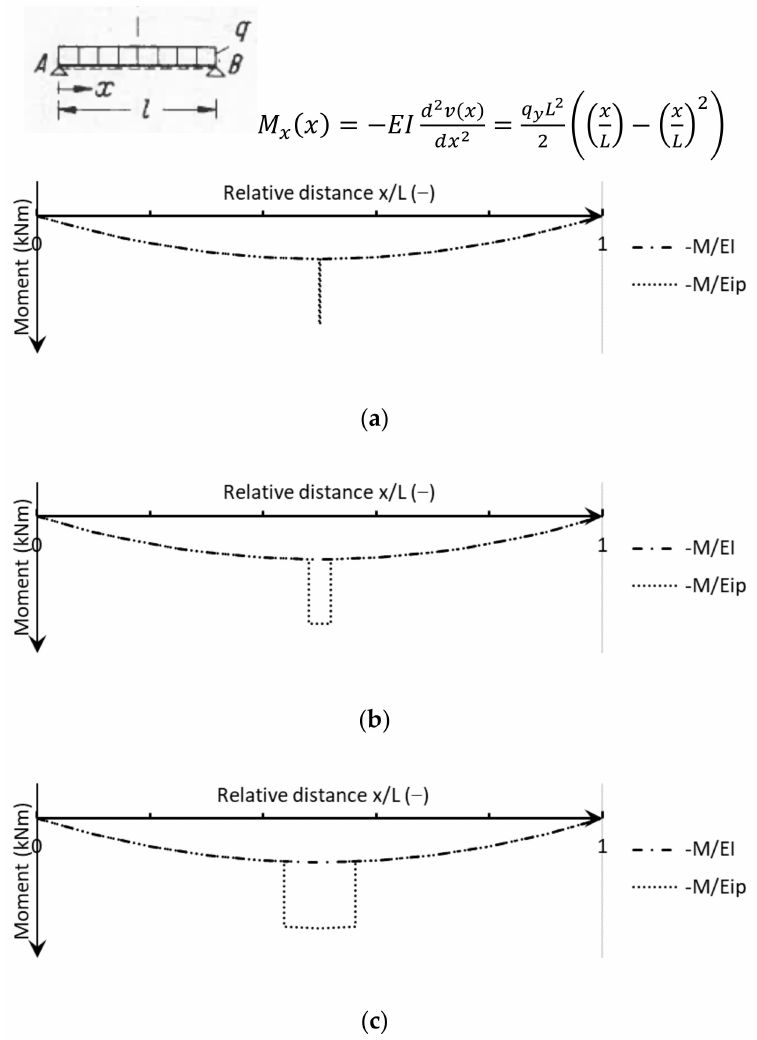
Figure 13. Moment–curvature relation along a line axis: ( a ) 1 cm joint; ( b ) 2 × 9.5 cm joint; ( c ) 2 × 30 cm